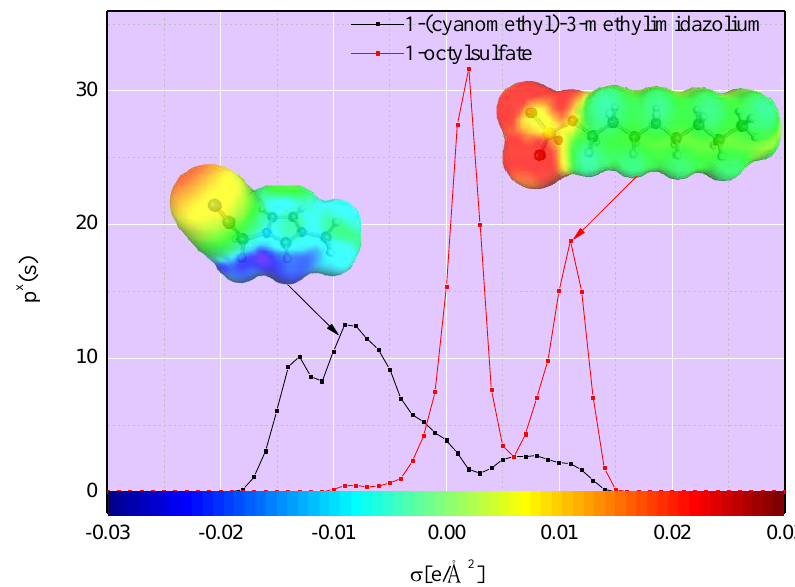
Figure 9. The screening charge density distribution area (S σ ) of representative cations and anions of ILs.